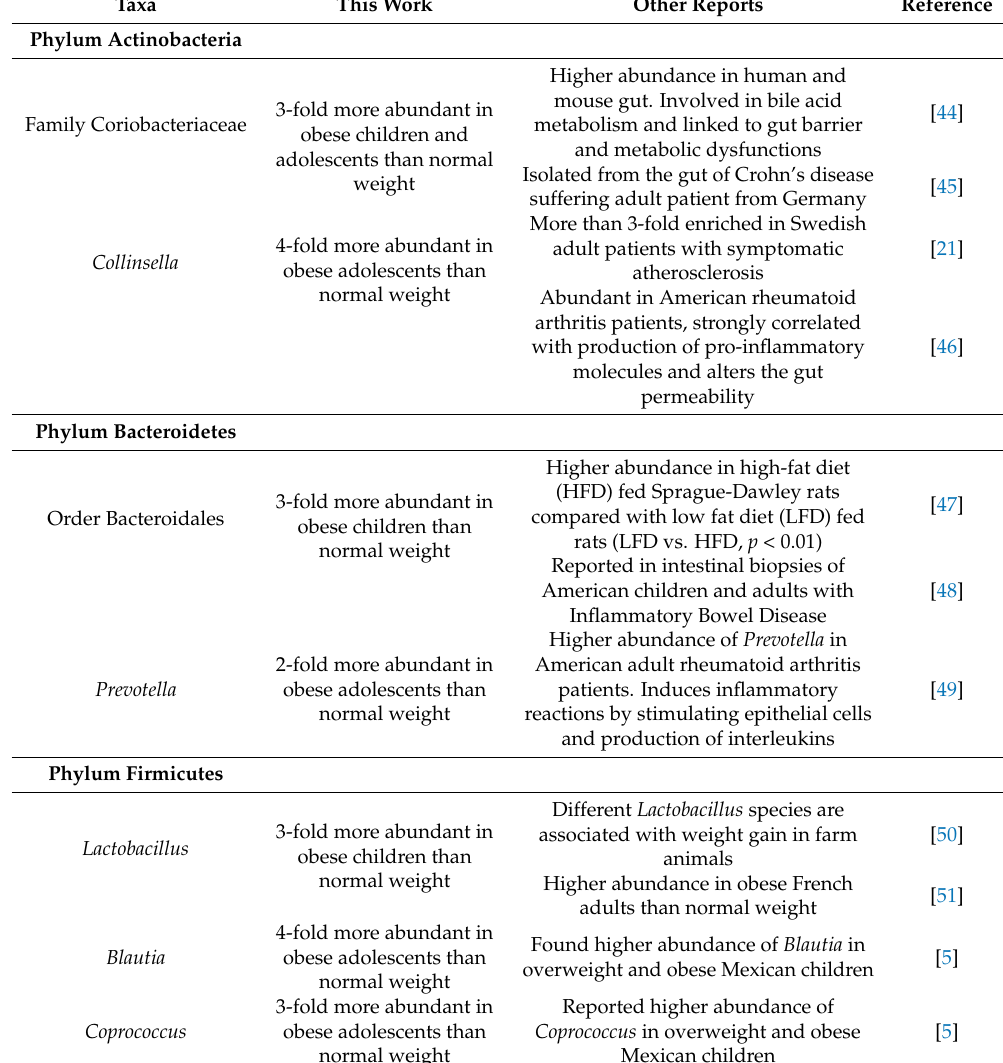
Table 4. Selected gut bacteria with significant changes in abundance according to linear discriminant analysis (LDA) effect size (LEfSe)